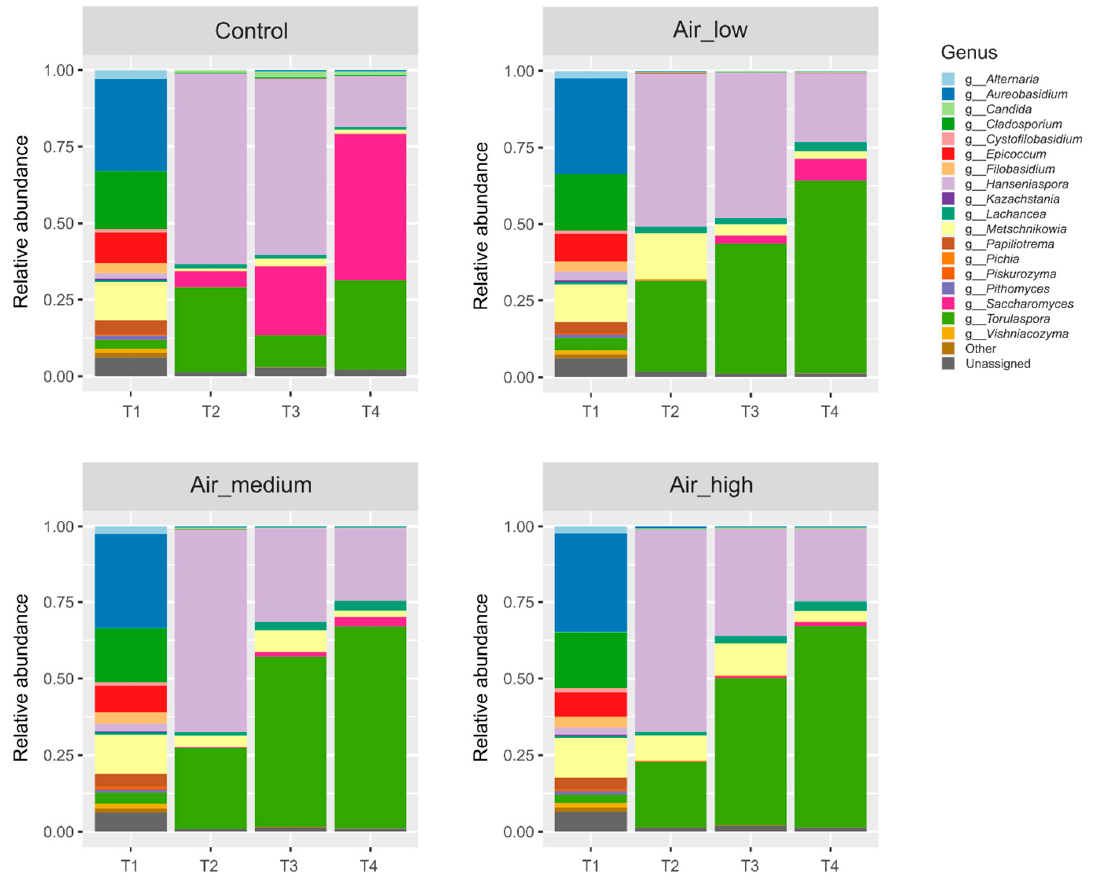
Figure 3. Genus-level metabarcoding analysis of community response to aeration given at 24 h post-grape crush in the 2020 vintage. Ferment samples were taken at four time points: T1, 0%; T2, 20%; T3, 55%; T4, 85% of sugar consumption. All sub-columns show mean percentages of three replicates.